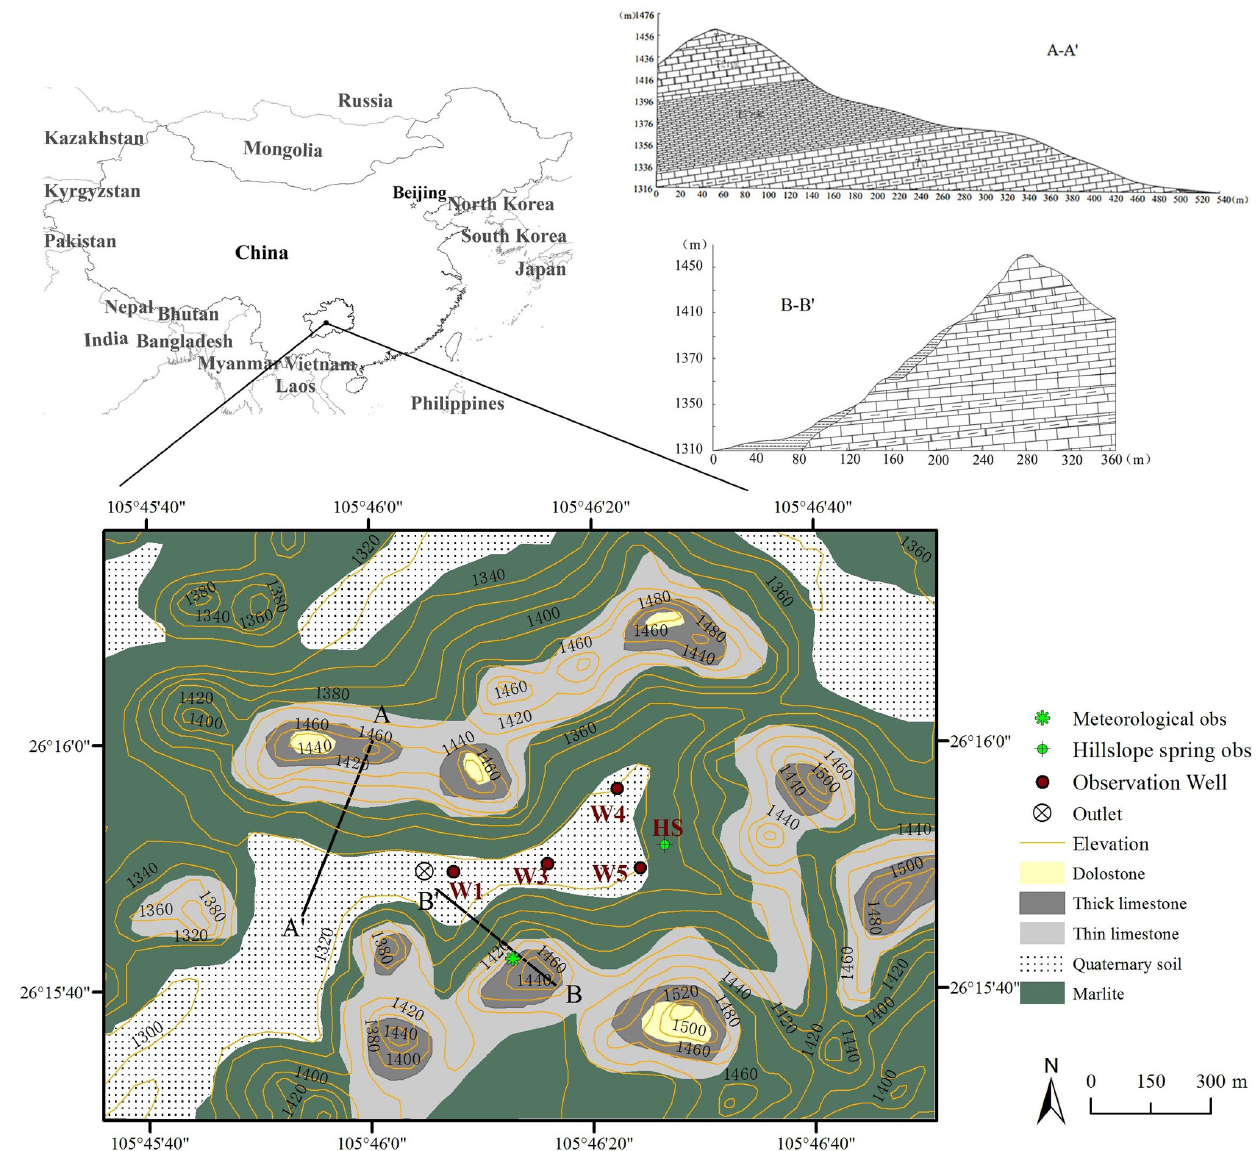
Figure 1. Map of location, geology, geomorphology and hydrological monitoring locations in Chenqi catchment. Discharge was measured at the outlet and hillslope (HS). Water was sampled from the outlet, HS and four depression wells. Table 1. Statistical summary of isotope data for rainfall, hillslope spring (HS), catchment outlet and depression wells. Obs δ D (‰) δ 18 O